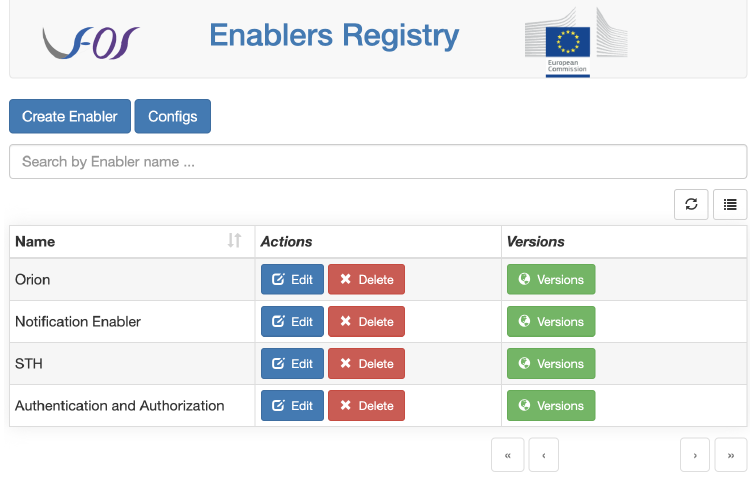
Figure 7. Enabler Registry management of enablers and their services.